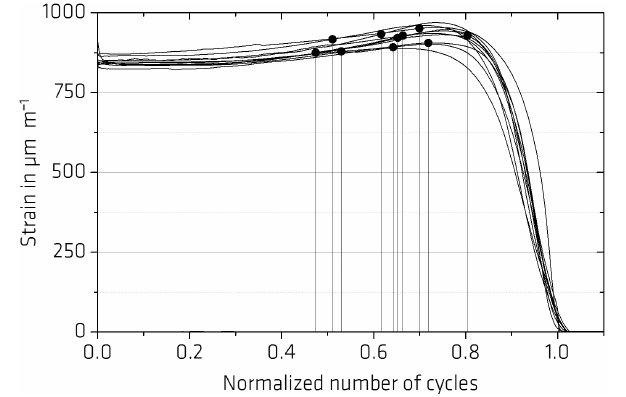
Figure 6. Strain curve of maximum and minimum strain, marked with different stages of crack propagation.